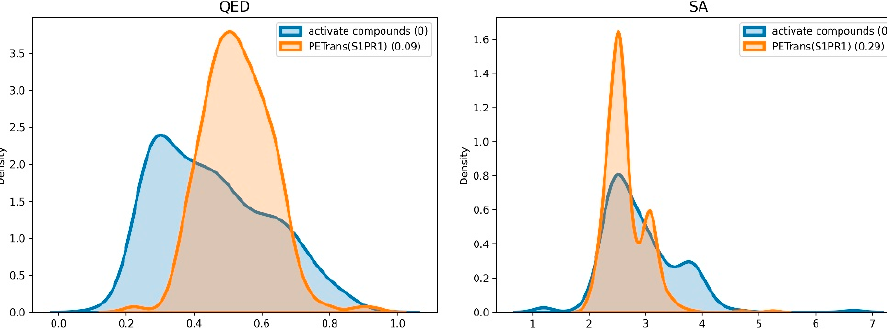
Figure A7. Distribution of the SA scores and the QED scores of the generated molecules for HTR1A.